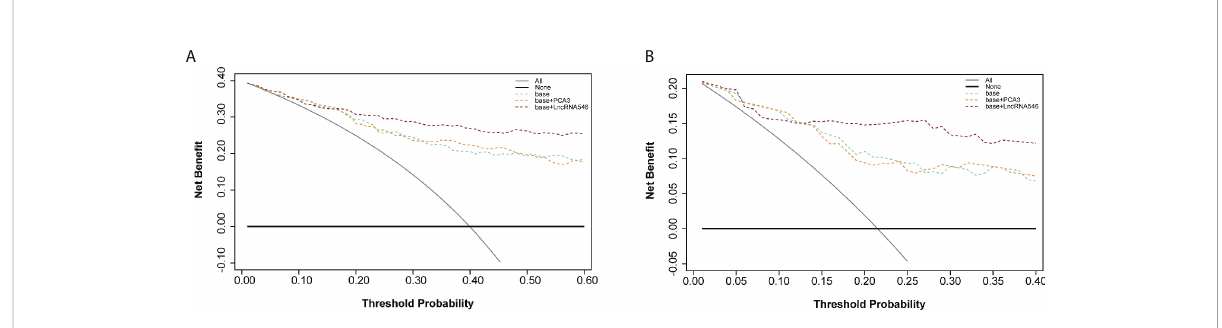
FIGURE 6 Decision curve analysis of predicting PCa with base, base+PCA3 score, base+LncRNA546 score model. (A) in the overall cohort. (B) in the PSA gray area